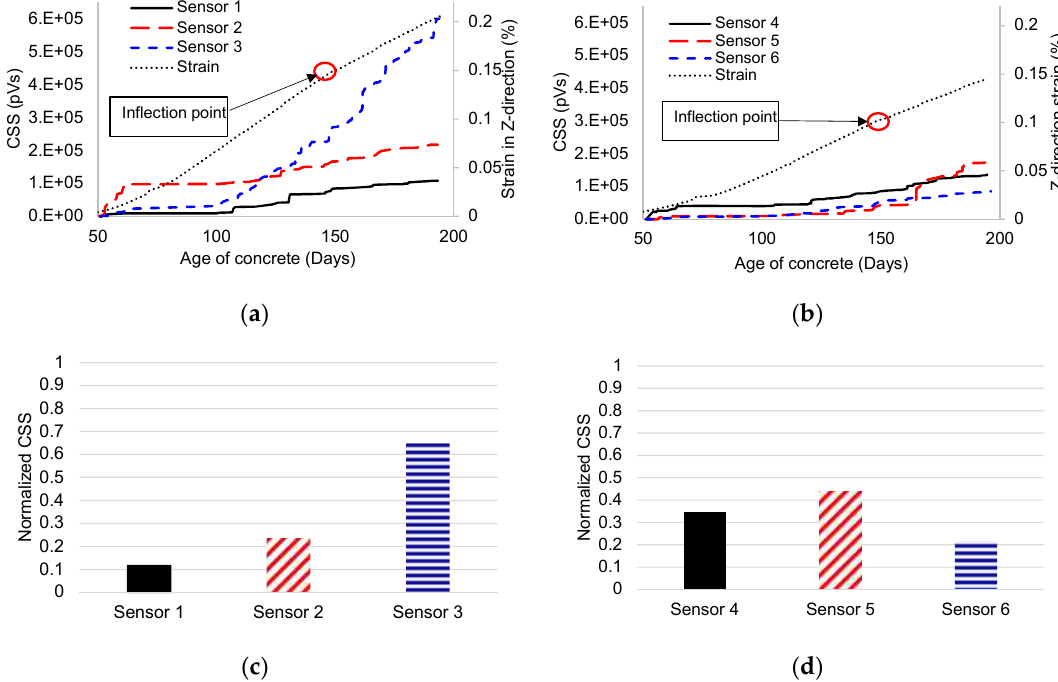
Figure 6. Cumulative signal strength (CSS) contribution for sensors. ( a ) CSS vs. age of concrete for confined specimen; ( b ) CSS vs. age of concrete for unconfined specimen; ( c ) Normalized CSS for confined specimen; ( d ) Normalized CSS for unconfined specimen.